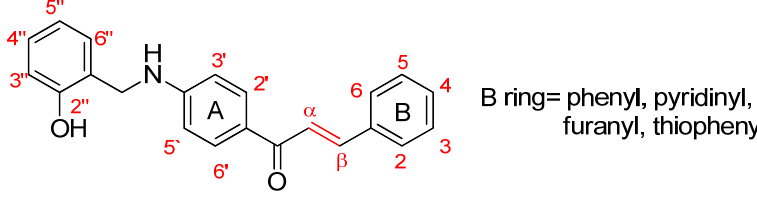
Figure 1. The general structure of benzylaminochalcones.